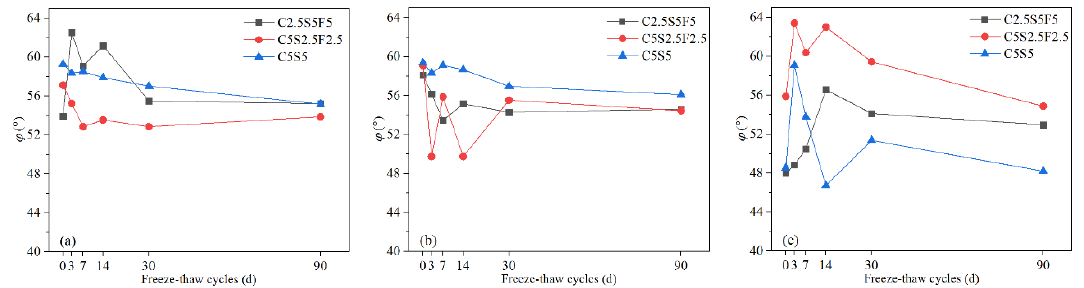
Figure 9. The ϕ values of Pb-CSCSs with the same contaminant content and di ff erent compound Figure 9. The φ values of Pb-CSCSs with the same contaminant content and different compound binders: ( a ) 0.05% Pb 2 + ; ( b ) 0.5% Pb 2 + , and ( c ) 1% Pb 2 + binders: ( a ) 0.05% Pb 2+ ; ( b ) 0.5% Pb 2+ , and ( c ) 1% Pb 2+ .